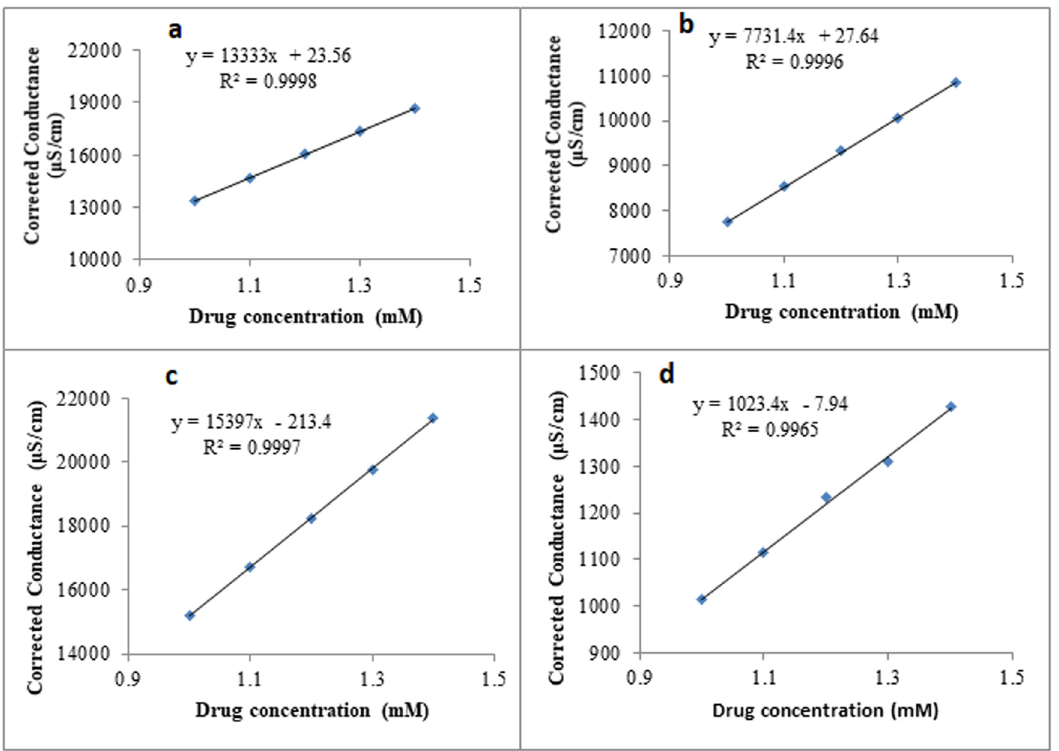
Figure 3: Calibration graph for imatinib ( a ) , sorafenib ( b ) , ge fi tinib ( c ) and bosutinib ( d ) displaying good linearity of the proposed method in the analyte concentration range of 1.0 – 1.4 mM, R 2 >